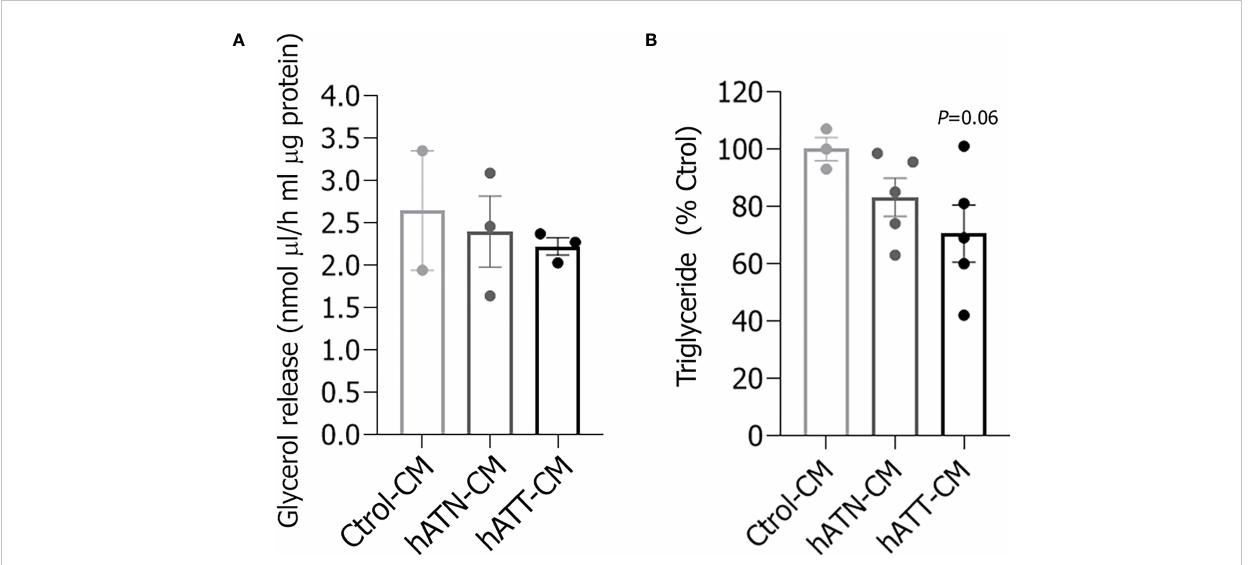
FIGURE 3 Effect of CM from hATN and hATT on triglyceride content in adipocytes and glycerol release into the medium. 3T3-L1 adipocytes were incubated with hATN-, hATT- or Ctrol-CM, and then the glycerol released into the media (A) and the triglyceride cell content (B) were determined by colorimetric assay at 505 and 570 nm, respectively (n = 3 experiments in duplicate). Student ’ s t-test with Welch´s correction was performed; p = 0.06 adipocytes incubated with hATT-CM vs. Ctrol-CM. Ctrol-CM, control conditioned media; hATN-CM, conditioned media from human normal